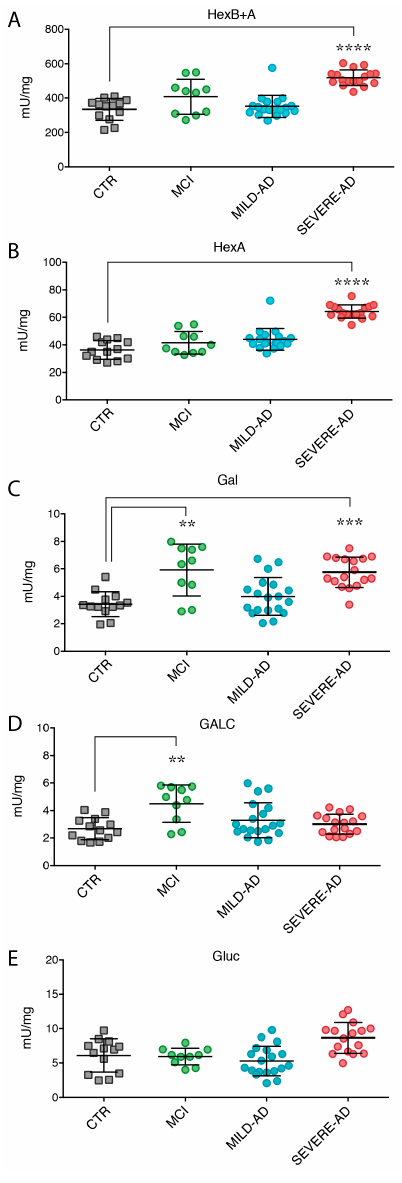
Figure 4. Lysosomal Hydrolases activity ( A – E ) in plasma of mild AD, severe AD, MCI, and control subjects. Levels of hydrolases were measured by using specific fluorogenic substrates (see Section 4 for details). Results were expressed as the mean ± SEM of five independent experiments, each in triplicates. ** p < 0.01, *** p < 0.001, **** p < 0.0001.